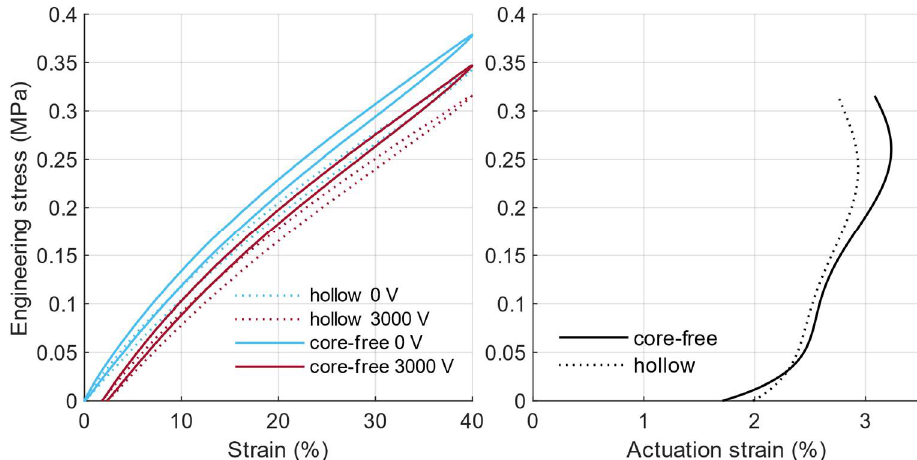
Figure 12. Stress plotted against strain for the hollow and core-free versions of the RDEAs ( left-hand side ) and the actuation strain ( right-hand side ). The actua-tion strain is calculated based on a fifth-order polynomial fitted on the loading and unloading branches of the 0 V and 3000 V stress-strain-curves, respec-tively.